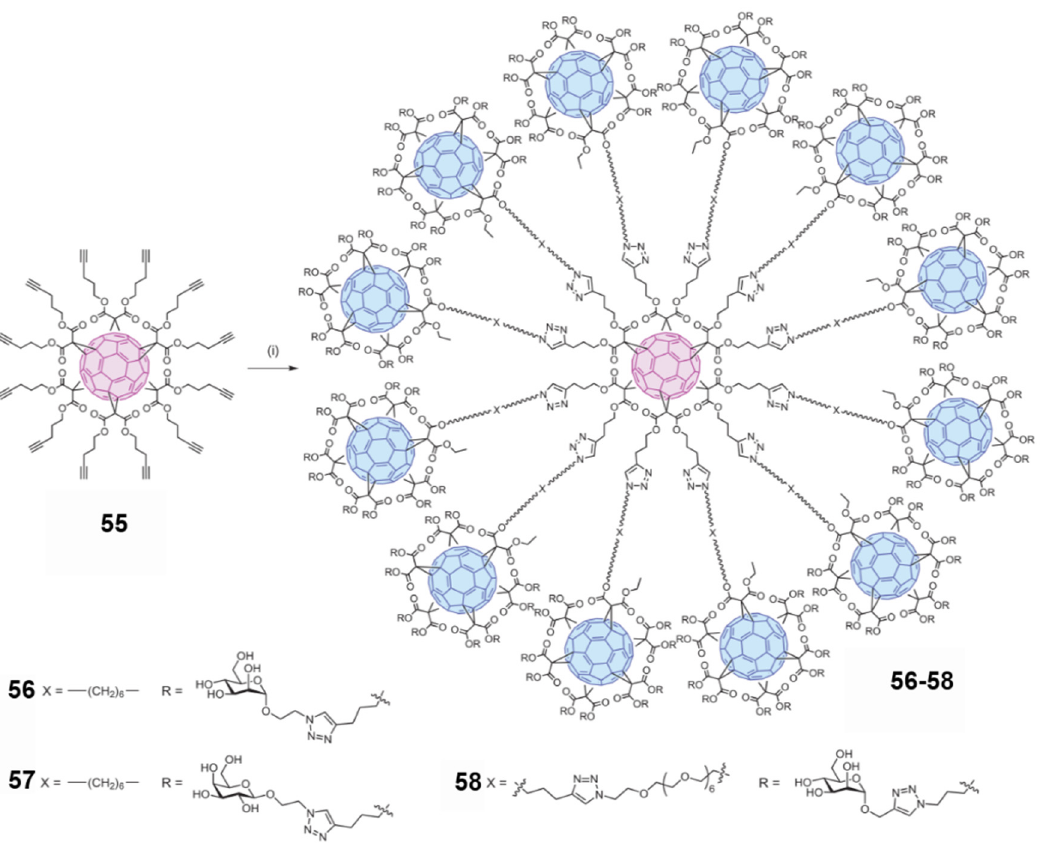
Figure 18. Synthesis of glycofullerenes 56–58 [45]. Adapted with permission from Ref [45]. Copyright 2015 Springer Nature.